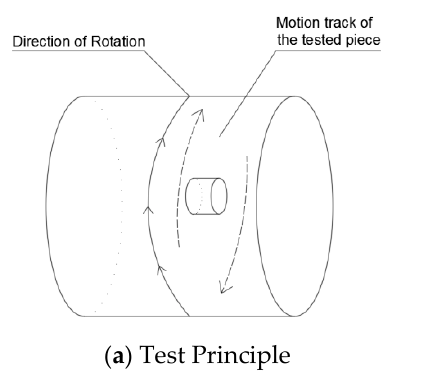
Figure 3. Cantabro